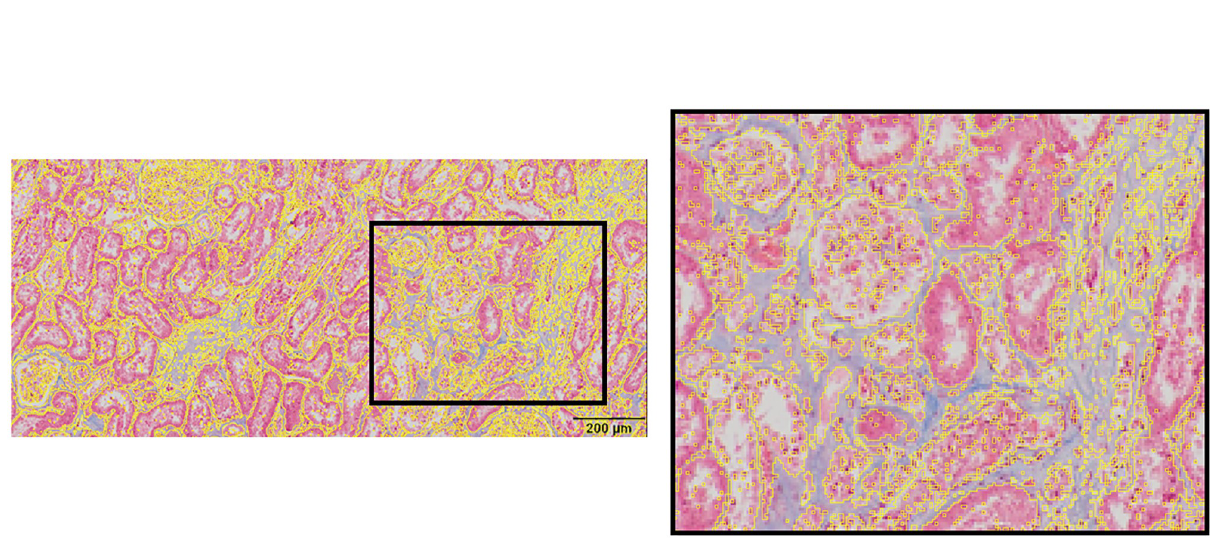
Fig 5. Computer imaging fibrosis scoring. A) Image showing ROIs generated using ImageJ color thresholding to measure the blue area in trichrome stained histology sections. B) Magnified view of the area of the black rectangle in 5A, showing the that these ROI contours include blue areas and exclude pink area and empty space.